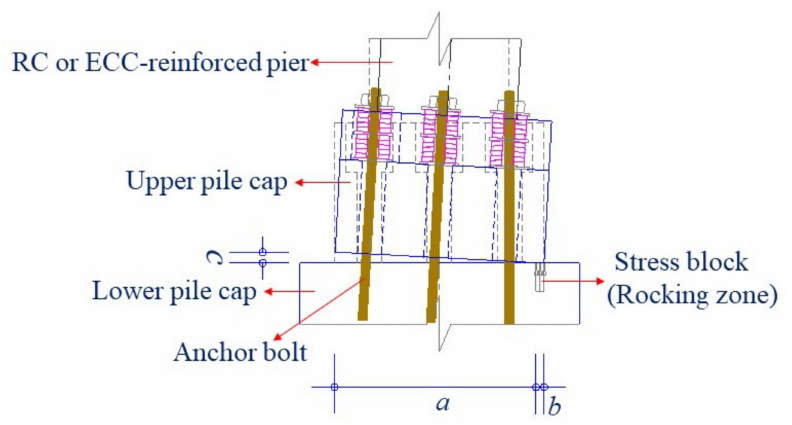
Figure 15. Schematic diagram of the uplift